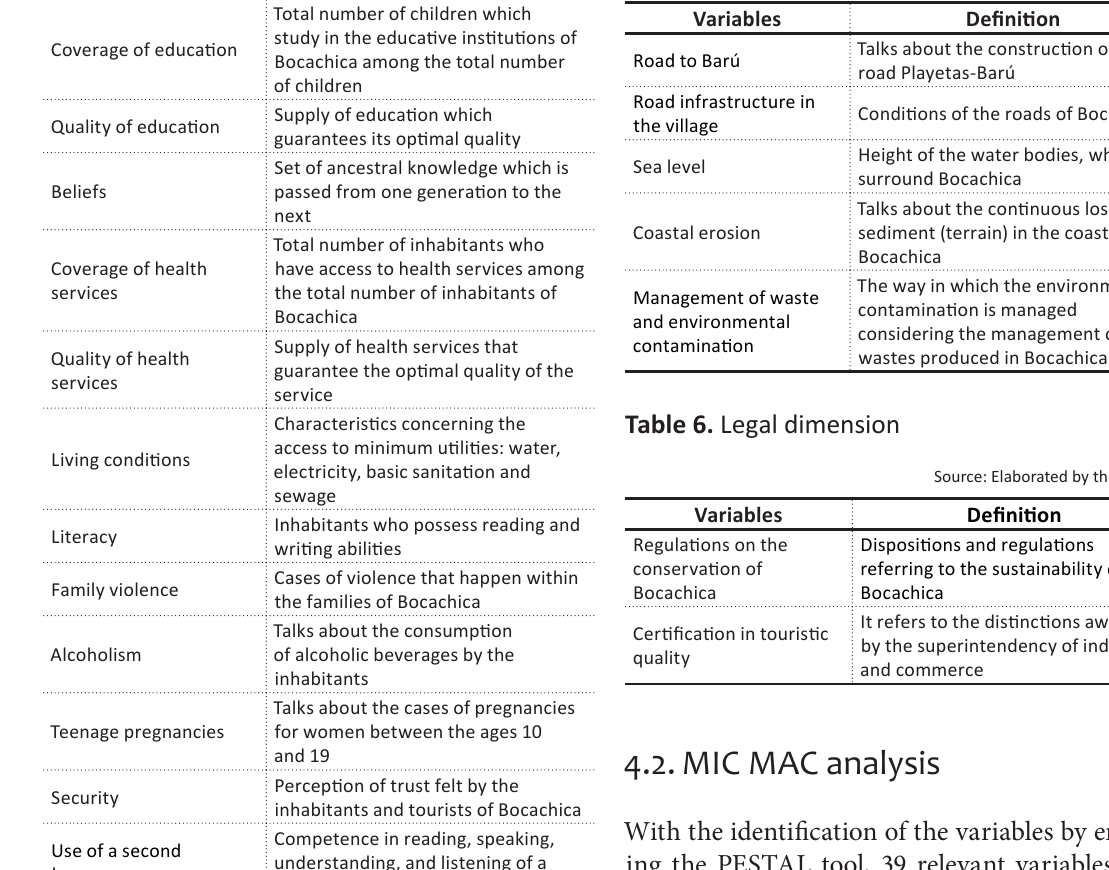
Table 3 (cont.). Sociodemographic dimension